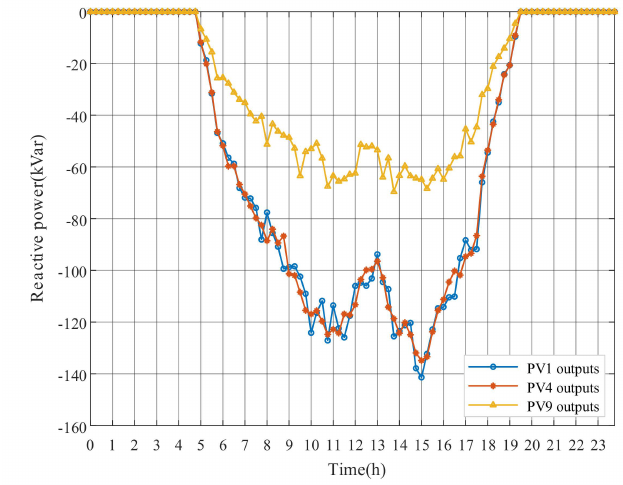
Figure 20. PV reactive power outputs with DRM strategy of Case 2.